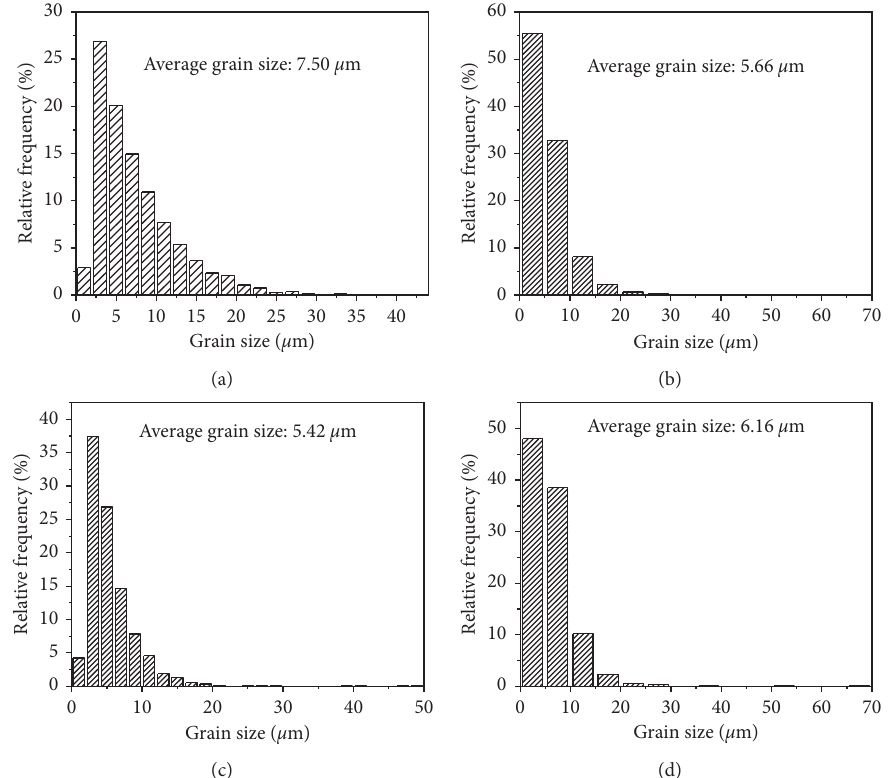
Figure 9: Grain size distributions of the alloys rolled at different temperatures which were determined from EBSD images: (a) 300 ° C, (b) 350 ° C, (c) 400 ° C, (d) 450 °